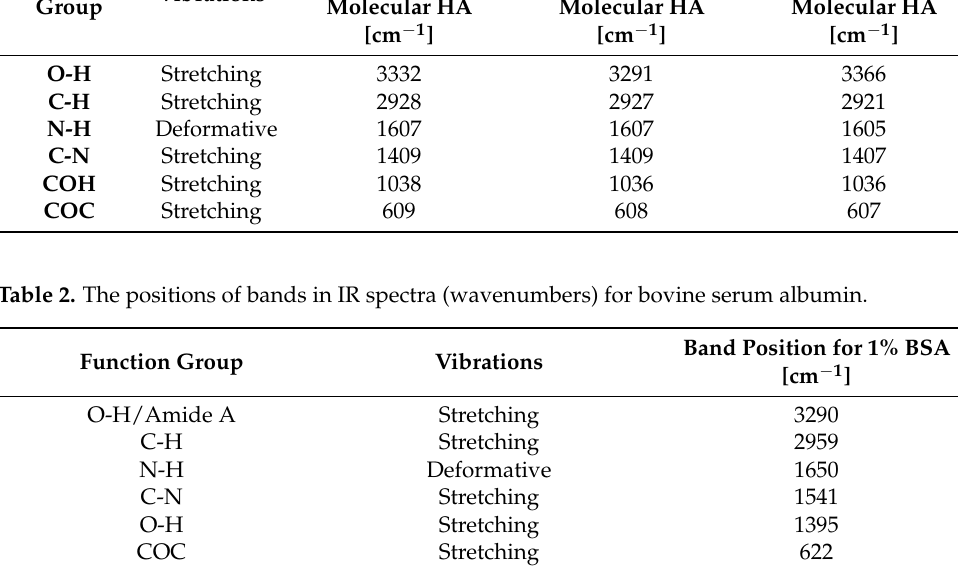
Table 3. The positions of bands in IR spectra (wavenumbers) for the mixtures of high-, low-, and ultralow-molecular-weight HA with bovine serum albumin.